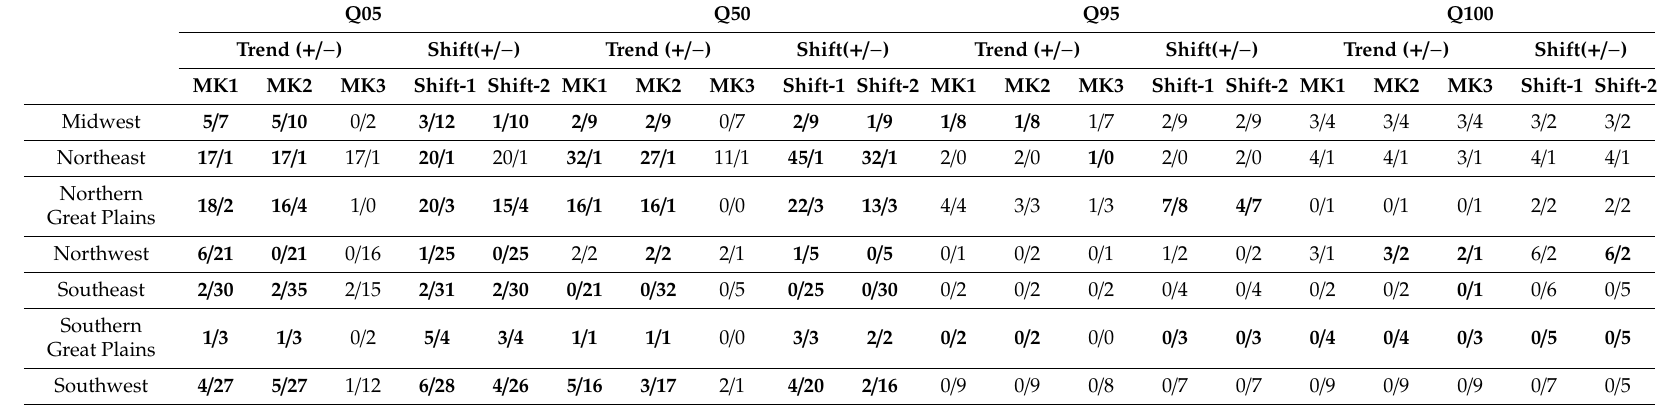
Table 3. Results for the Mann–Kendall (MK) test along with Pettitt Shift before / after accounting lag-1 autocorrelation (Shift-1 / Shift-2) for streamflow percentiles. The entries in bold identify that the region was field significant at p ≤